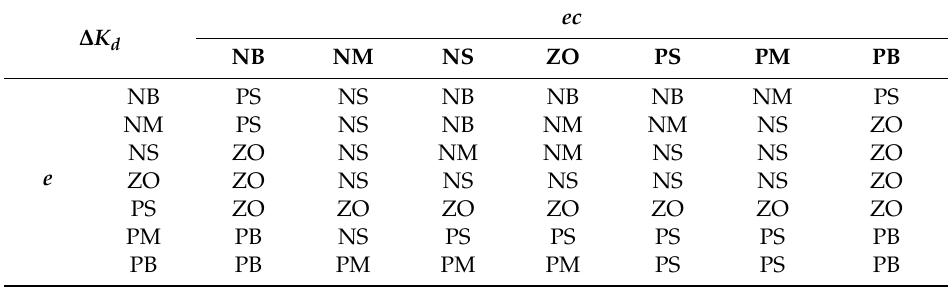
Table 4. ∆ Kd fuzzy control